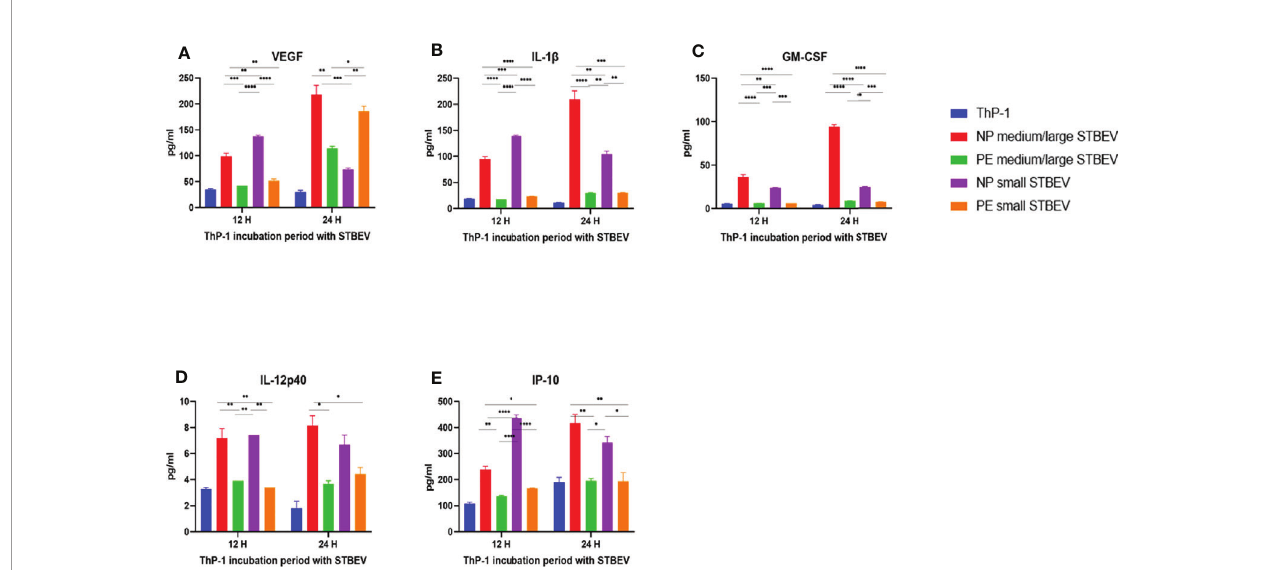
FIGURE 10 | Multiplex array analysis of the supernatants of differentiated THP-1 cells treated with STBEVs from NP and PE placentae. Concentrations of VEGF (A) , IL-1 b (B) , GM-CSF (C) , IL-12p40 (D) and IP-10 (E) released by THP-1 cells at 12 and 24 h incubation with STBEVs. Values calculated as Mean ± SEM of value from cells treated with 1 X 10 9 of STBEVs. Bars without error bars represent data whose SEM are close to zero and could not be adequately plotted by prism. To determine signi fi cant difference in production, a one-way ANOVA was performed on data: *p ≤ 0.05, **p ≤ 0.01, ***p ≤ 0.001 and ****p ≤